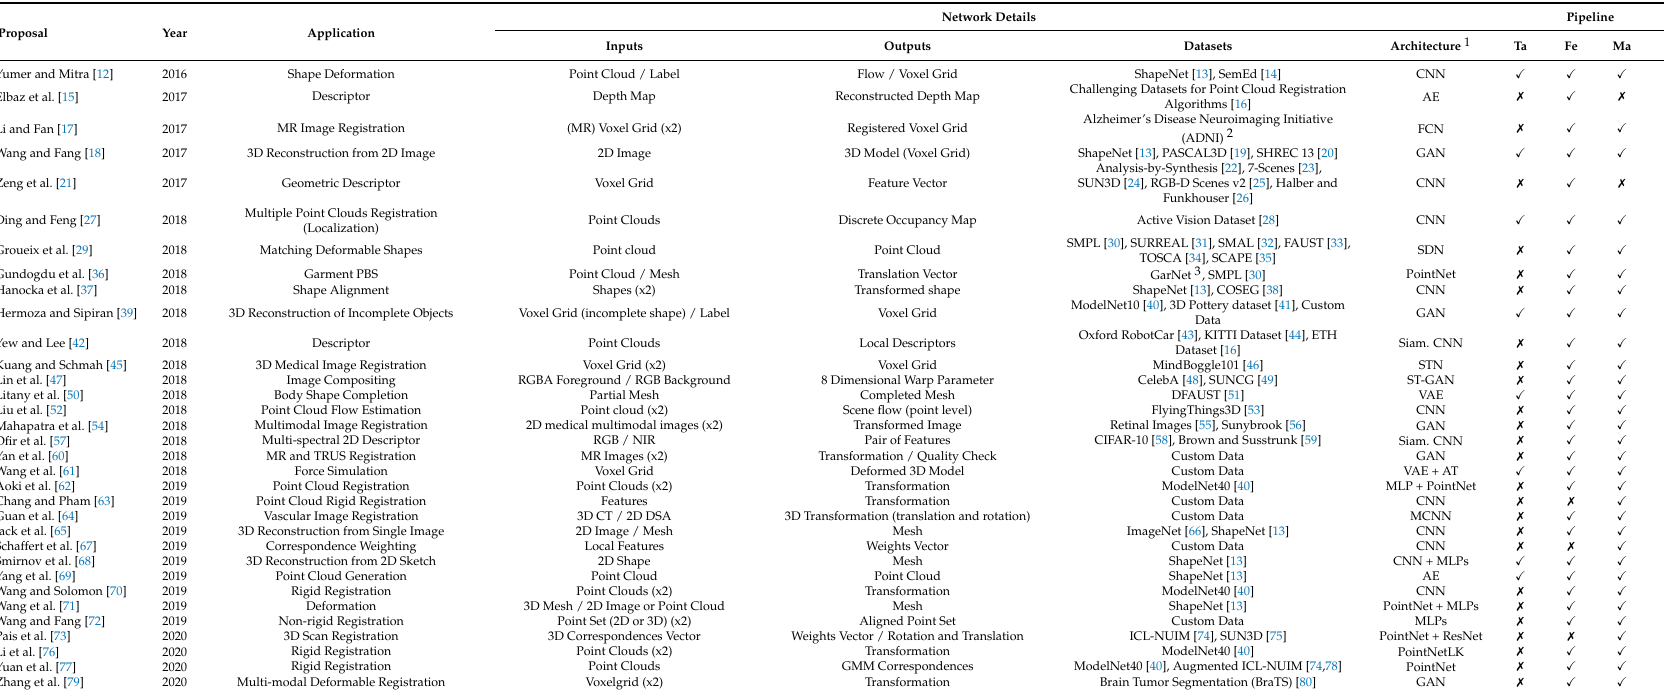
Table 1. Summary of the reviewed methods. It shows the application, inputs, and outputs; the employed datasets; and the architecture of the network. The right columns record the stage of the traditional registration pipeline that the network addresses ( Ta , Ta rget; Fe , Fe atures; Ma , Ma tching; Tr , Tr